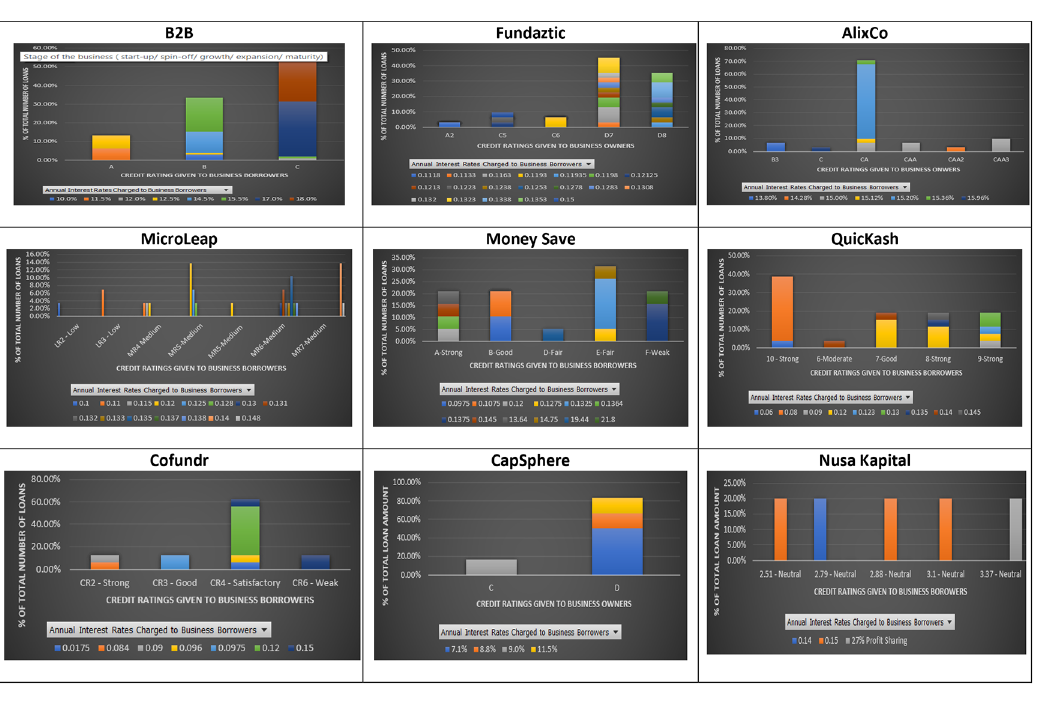
Figure 1. Interest rates and credit ratings at nine P2P lending